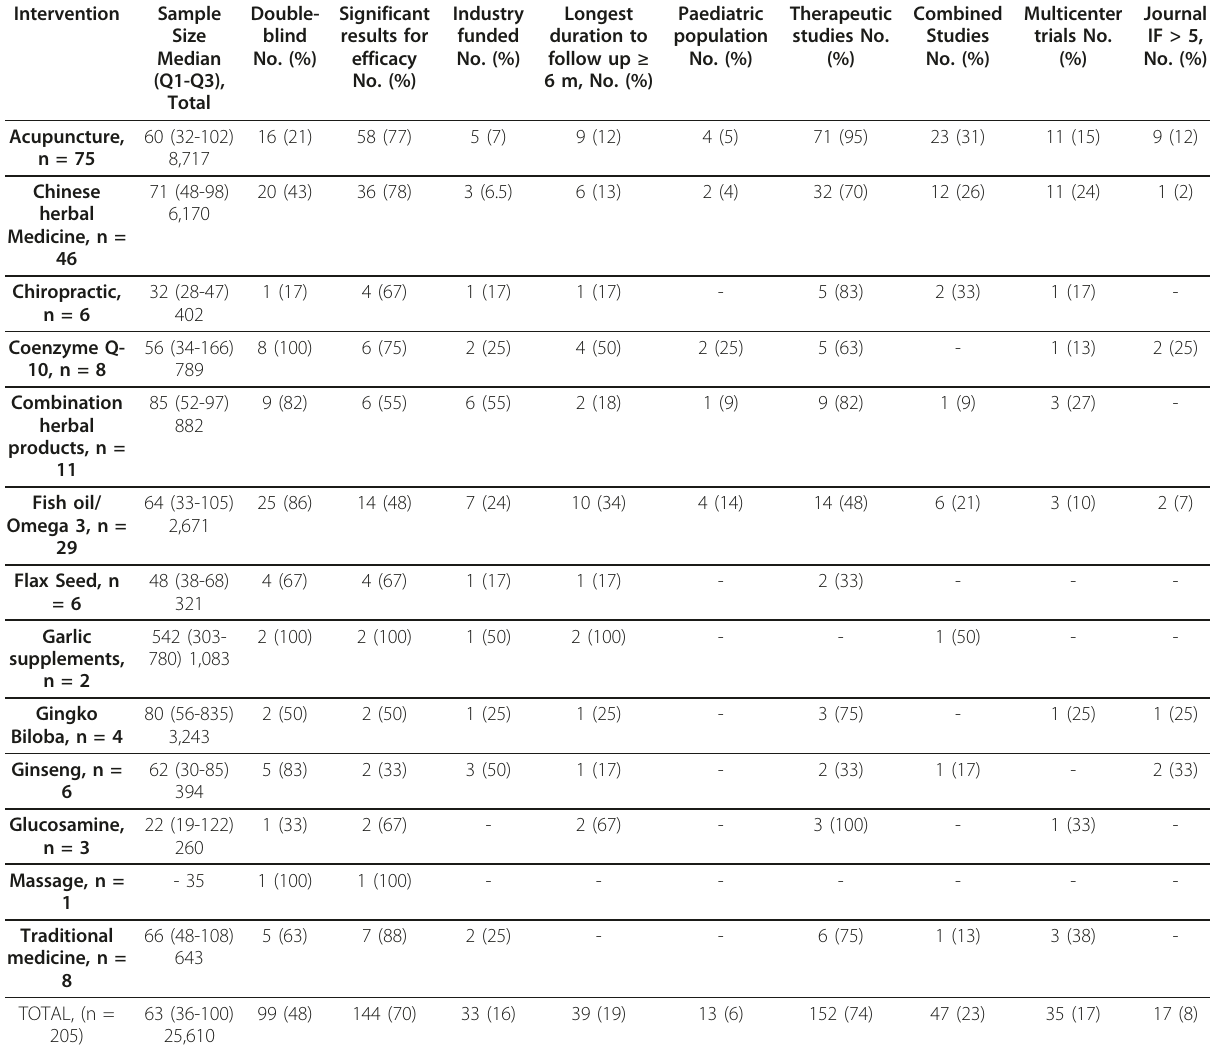
Table 1 Characteristics of included CAM RCTs